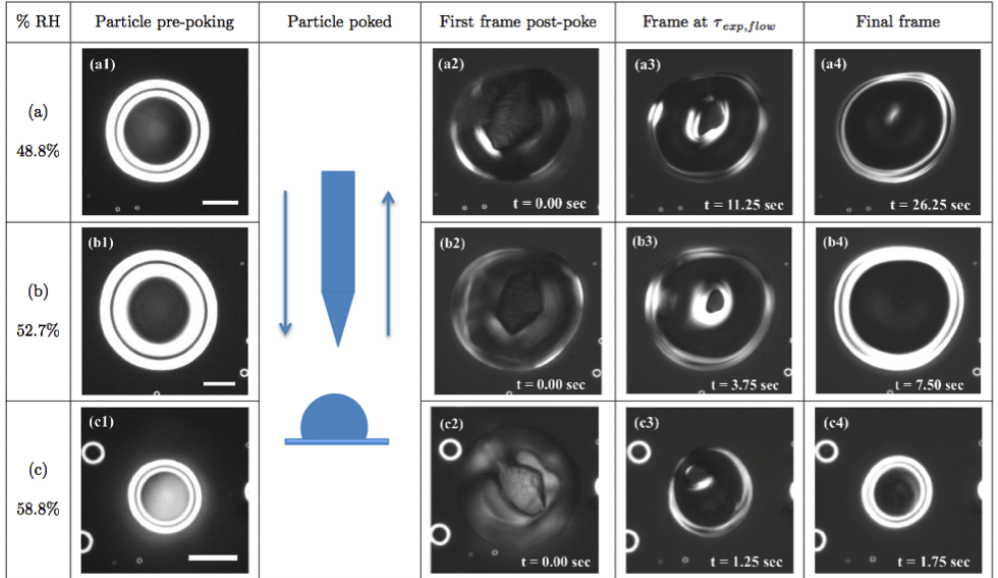
Figure 3. Optical images of sucrose–water particles poked at RHs of (a) 48.8, (b) 52.7, and (c) 58.8% recorded during typical poke-flow experiments. Images a1, b1, and c1 correspond to the particles before they are poked. Images a2, b2, and c2 correspond to the first frame post-poke (i.e. the first frame after the needle has been removed). Images a3, b3, and c3 correspond to images of the experimental flow time, τ exp, flow , the point at which the equivalent area diameter of the hole at the centre of the particle has decreased to 50% of its original size. Images a4, b4, and c4 correspond to the final frame recorded, at which point each particle has re-attained its original spherical cap geometry. Scale bar: 20µm. Table 1. Experimental parameters used when simulating flow with COMSOL for the sucrose–water experiments. Surface